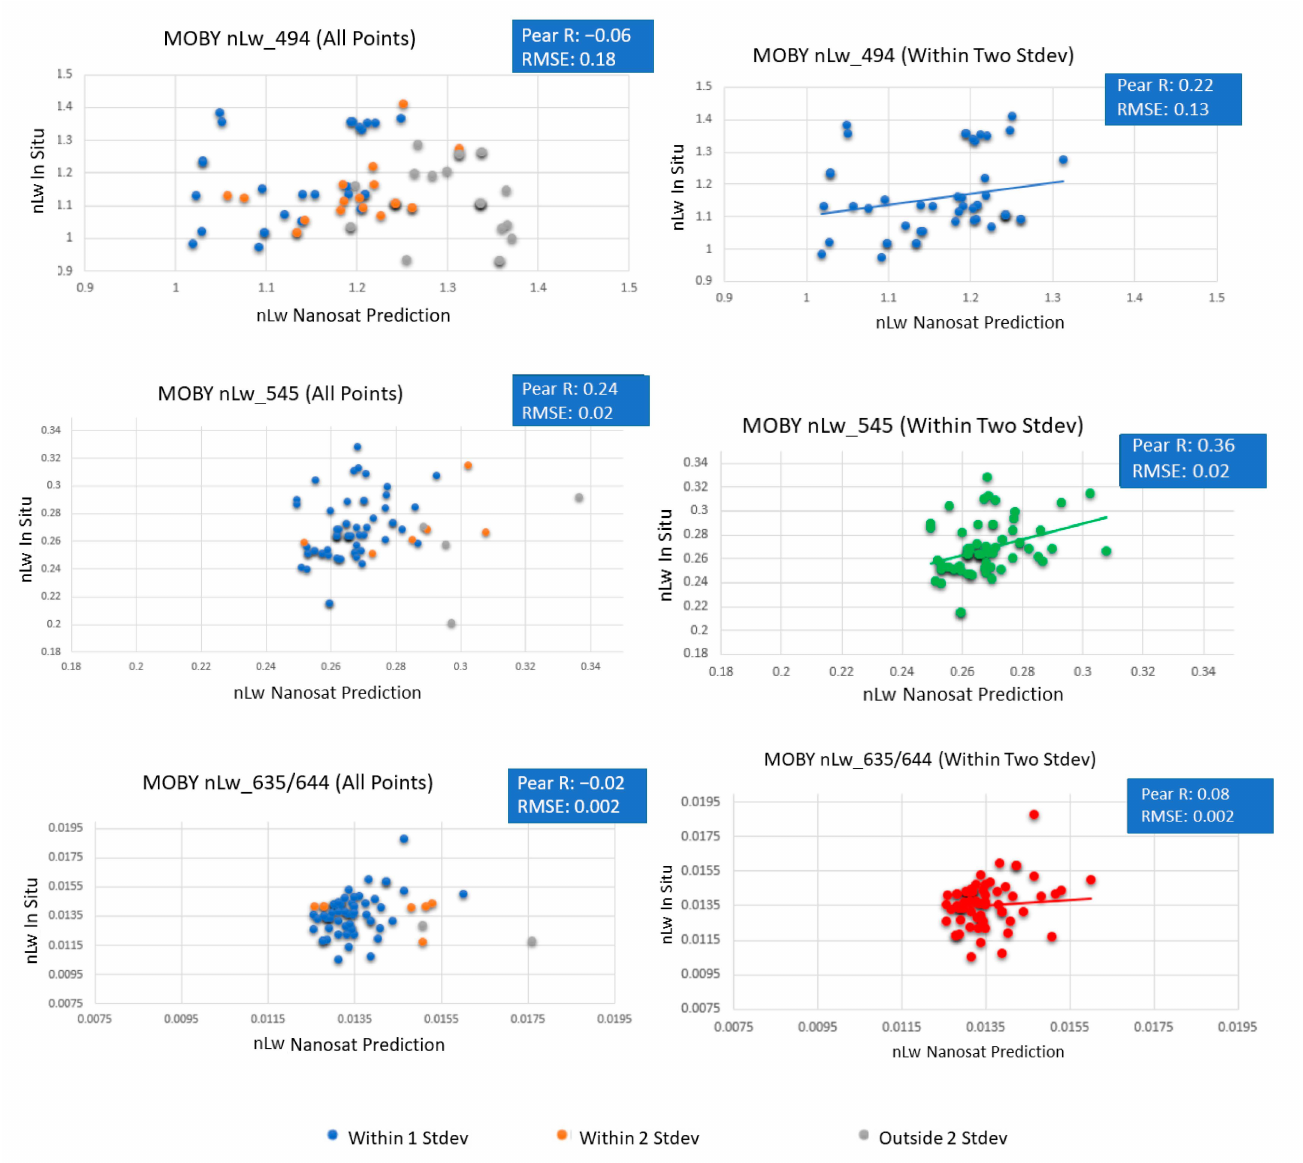
Figure 9. Planet PlanetScope predicted nLw vs. MOBY in situ nLw. Top left : nLw_494 unfiltered. Top right : nLw_494 filtered. Middle left : nLw_545 unfiltered. Middle right : nLw_545 filtered. Lower left : nLw_635/644 unfiltered. Lower right : nLw_635/644